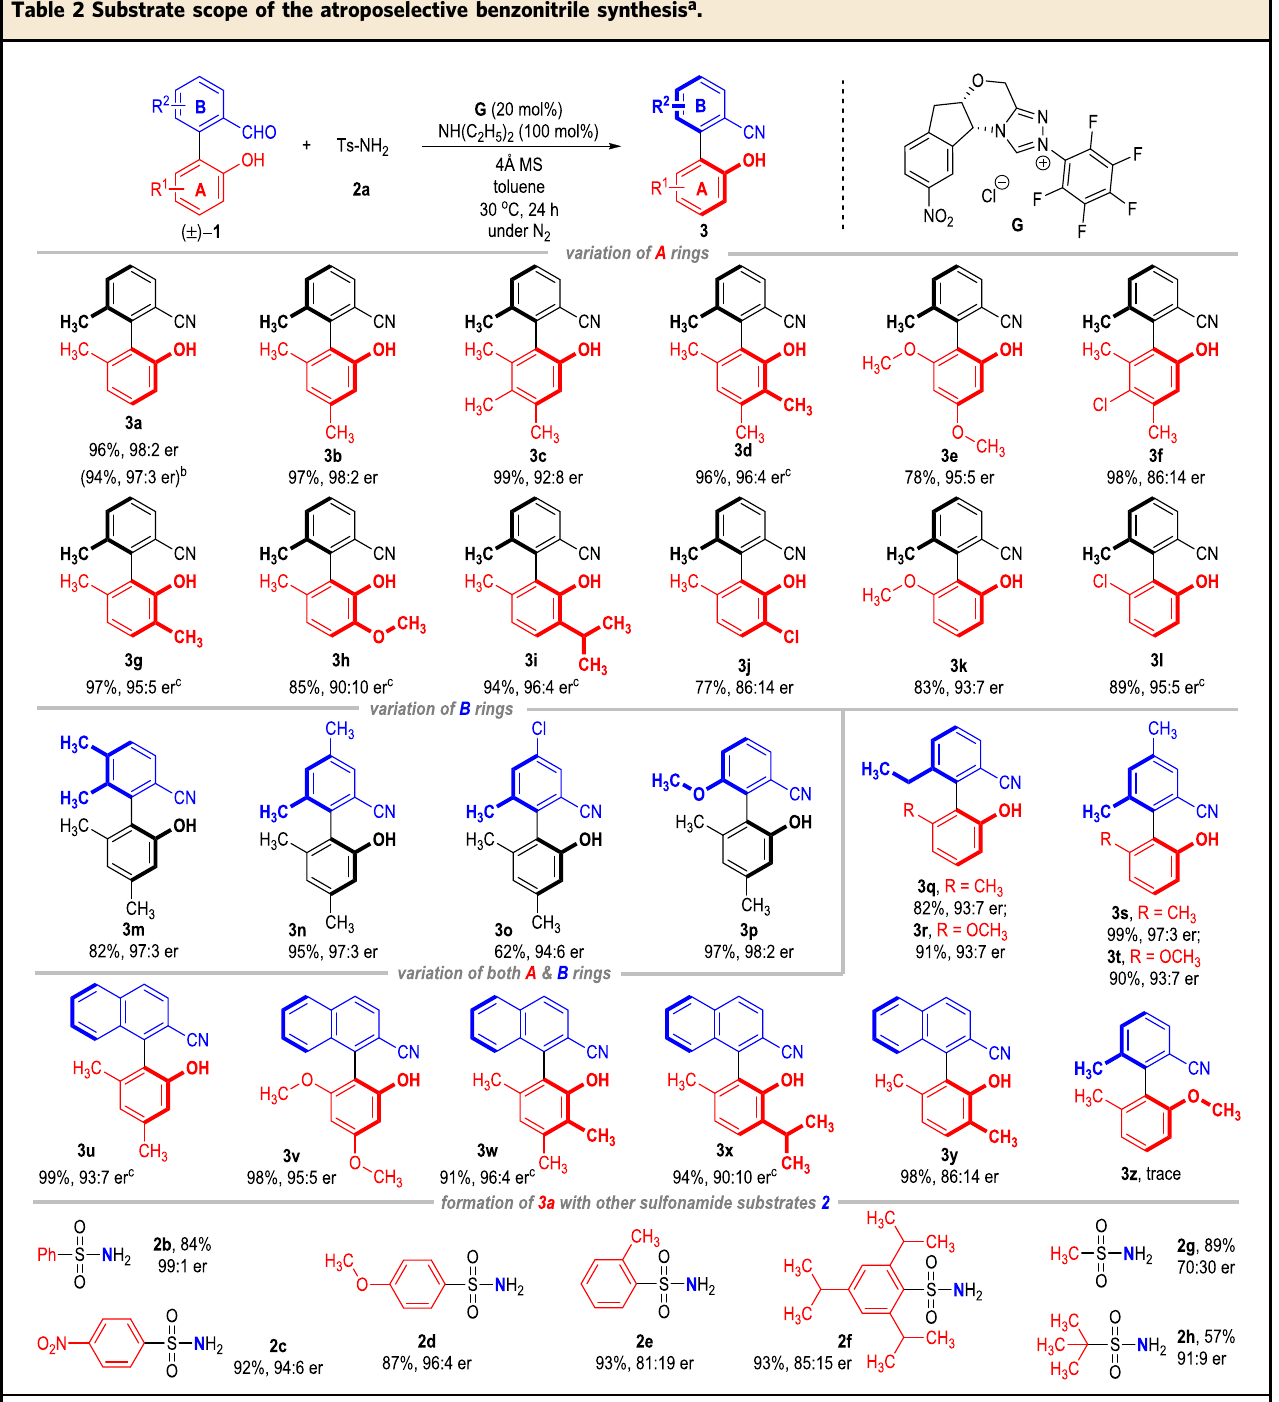
Table 2 Substrate scope of the atroposelective benzonitrile synthesis a